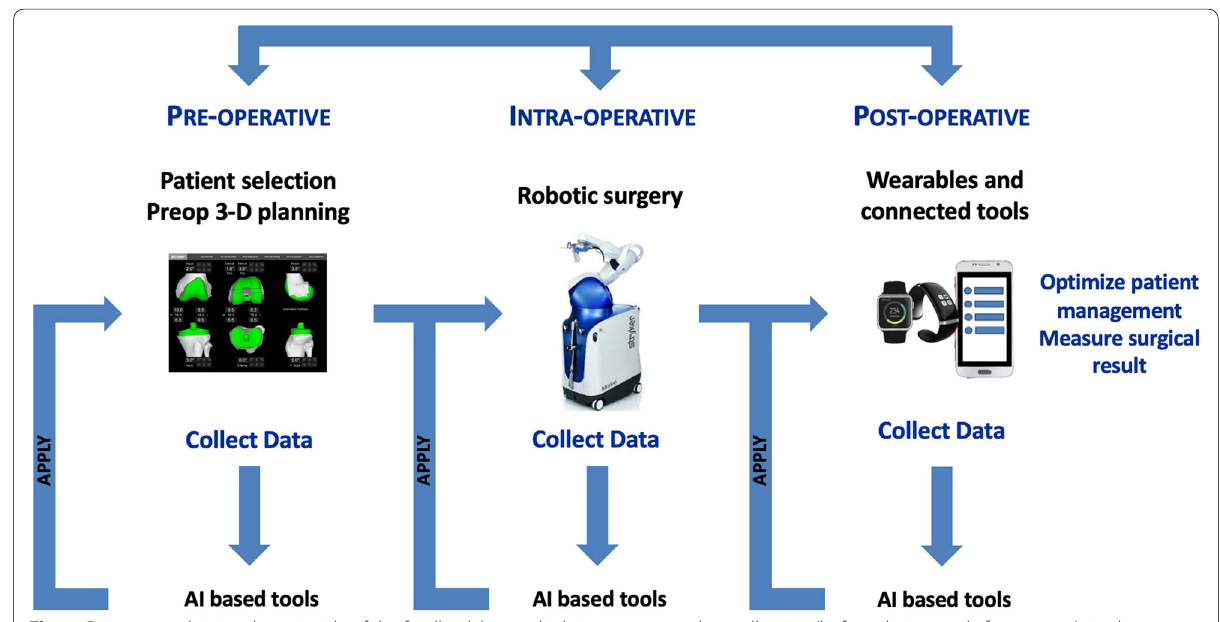
Fig. 4 Diagram explaining the principle of the feedback loop, which interconnects data collection (before, during, and after surgery) via the connected tools to create mega data information for adjusting the surgical